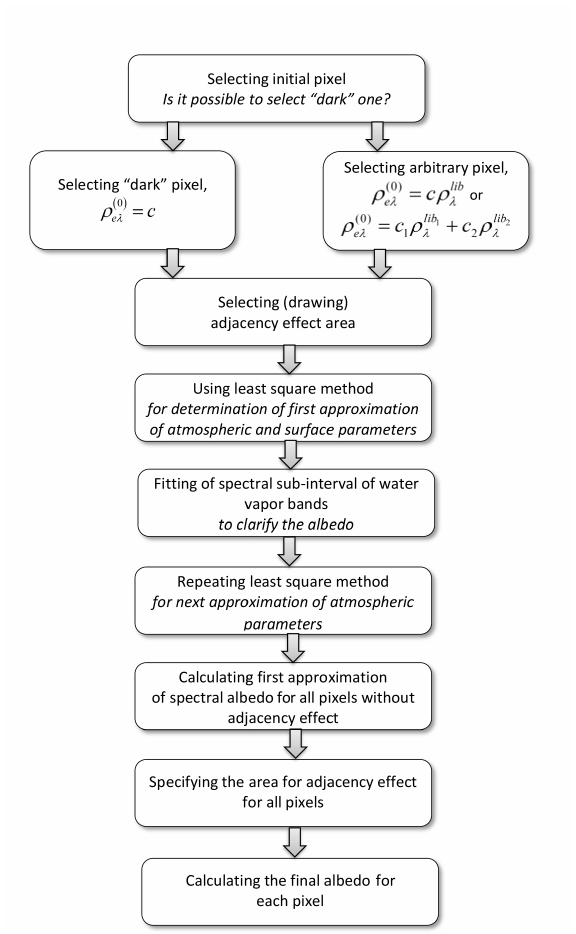
Figure 1. Pipeline of atmospheric correction of hyperspectral image